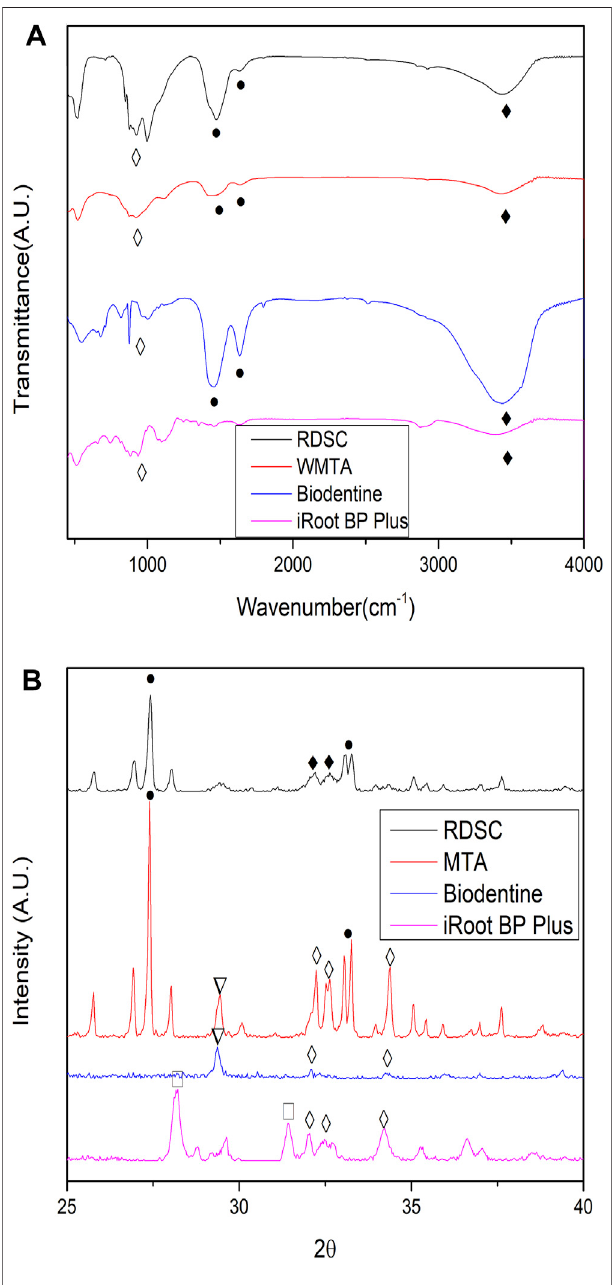
FIGURE 2 | (A) Fourier transform infrared spectra and (B) XRD patterns of four pulp-capping agents.